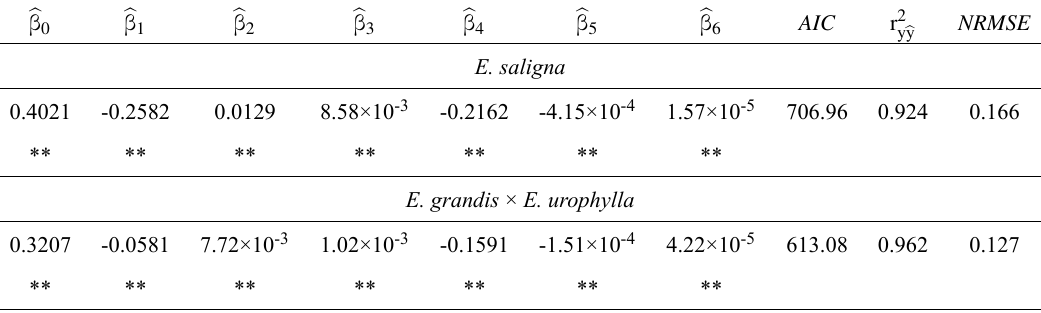
Goodness of fits to estimate residual biomass in wood harvesting of E. saligna and E. grandis × E. urophylla stands.